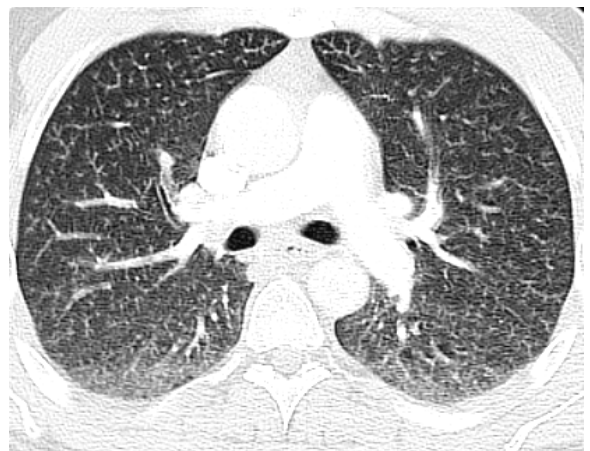
Figure 1. Axial computer tomography angiography (CTA) at the level pulmonary arteries showing extensive military densities in the bilateral lung fields with no evidence of embolism.